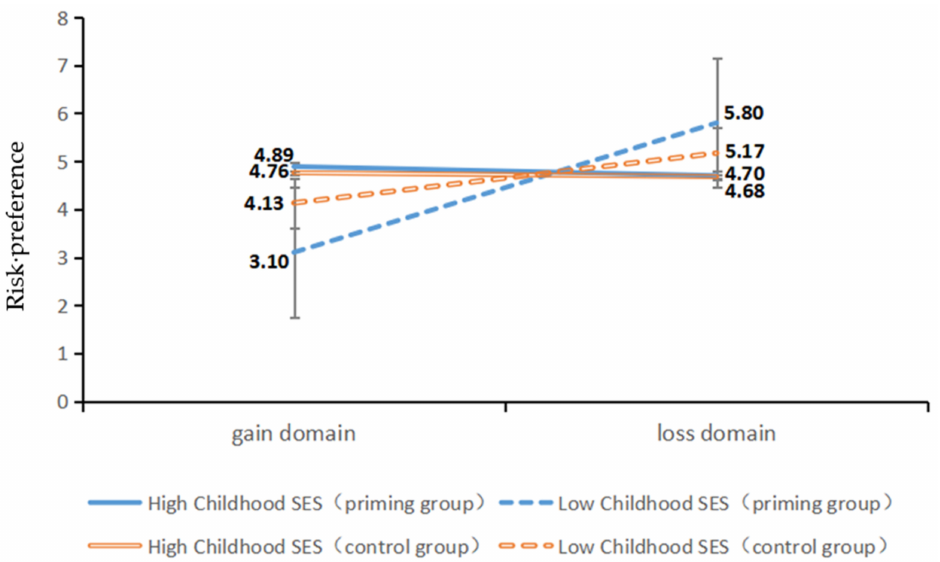
Figure 3. The effect of childhood SES on adolescents’ risk behaviors in the gain and loss domains under psychological threat